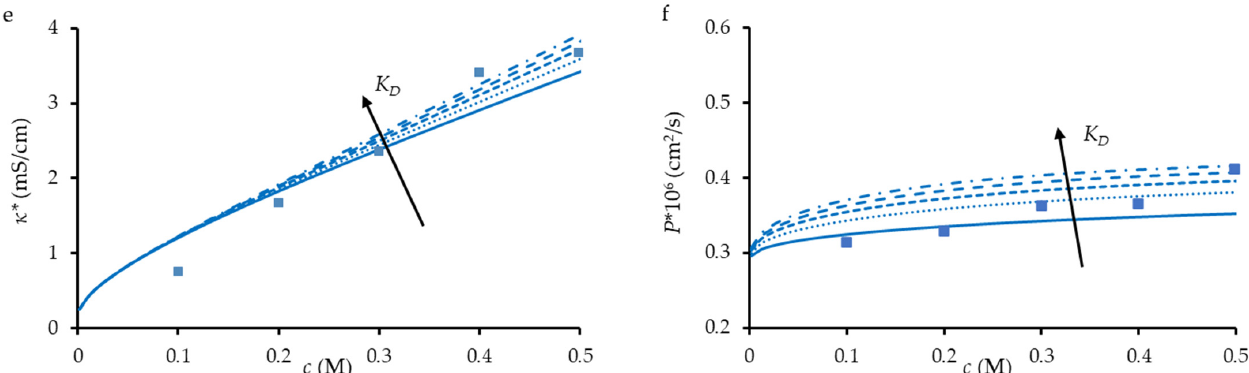
Figure 6. Experimental (dots) and simulated (lines) electrical conductivity ( a , c , e ) and diffusion permeability ( b , d , f ) of TEM#811 as functions of NaCl concentration. Simulations were performed using the parameters presented in Table 2. In each figure, one parameter was varied, while others were fixed: Q mb = 0.005, 0.010 . . . 0.025 M ( a , b ), α = 0.25, 0.3 . . . 0.5 ( c , d ), and K D = 0.1, 0.3 . . . 0.9 ( e , f ).